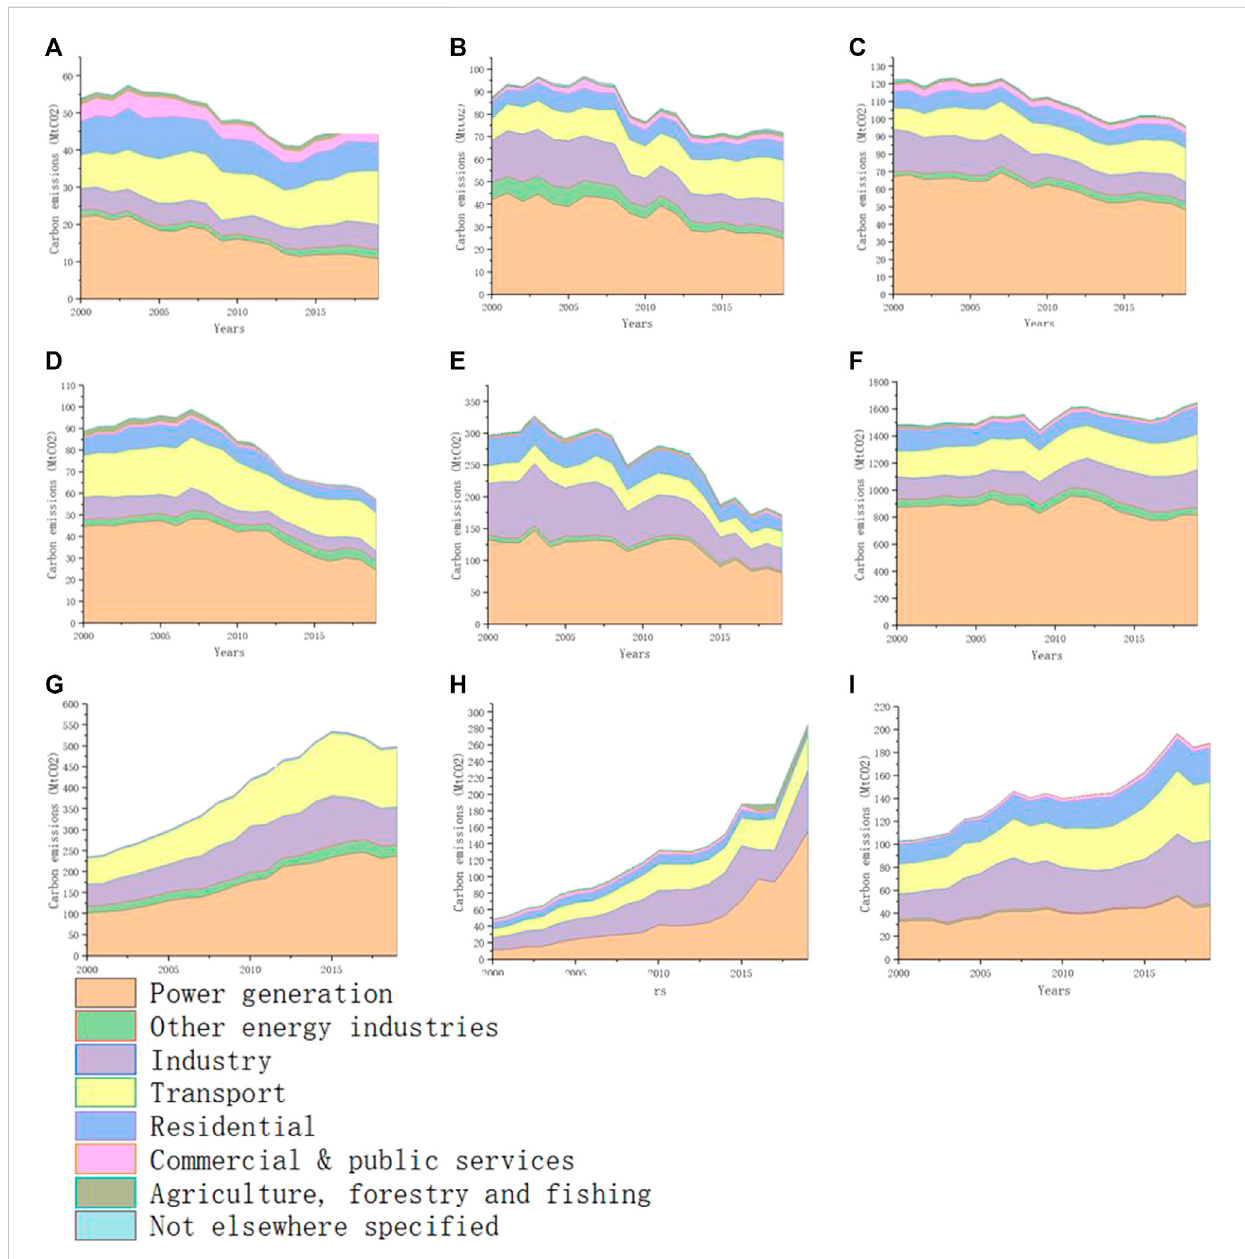
Share of carbon emissions generated by each sector in nine countries. (A) Hungary; (B) Romania; (C) Czech Republic; (D) Greece; (E) Ukraine; (F) Russian Federation; (G) Saudi Arabia; (H) Pakistan. (I)